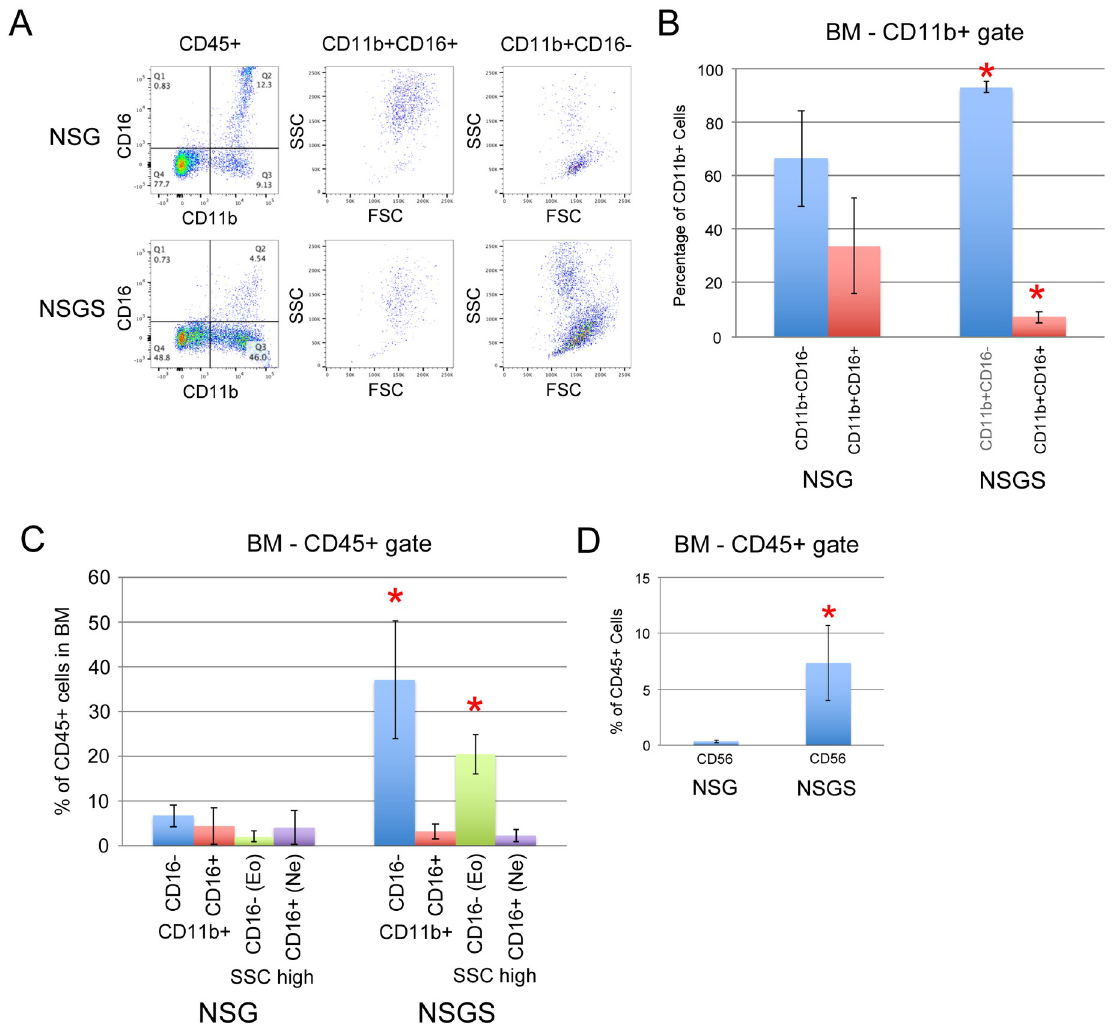
Fig 2. Differential myeloid and NK differentiation in NSGS compared to NSG. A) Representative FACS analysis of BM from UCB CD34+ engrafted mice co-stained with CD11b and CD16 antibodies at 15 weeks of engraftment. Average and standard deviation of a cohort of mice stained and analyzed as in A and represented as percentage of B) CD11b+ cells or C) CD45+ cells. D) Average percentage of CD56+ NK cells in BM of the same engrafted mice. Asterisks indicate p value less than 0.05 by Student’s T Test.